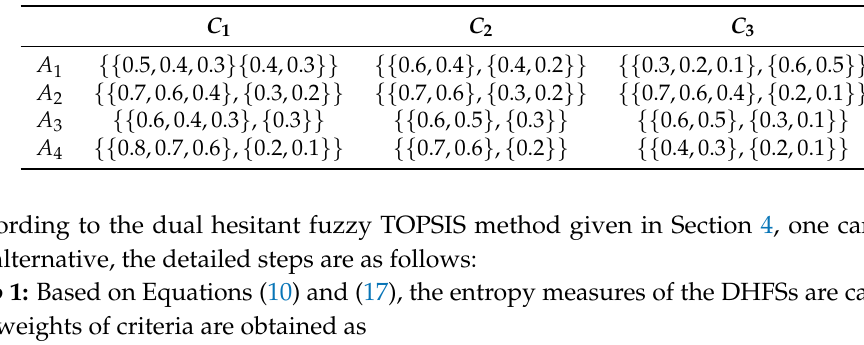
Table 1. Dual hesitant fuzzy decision